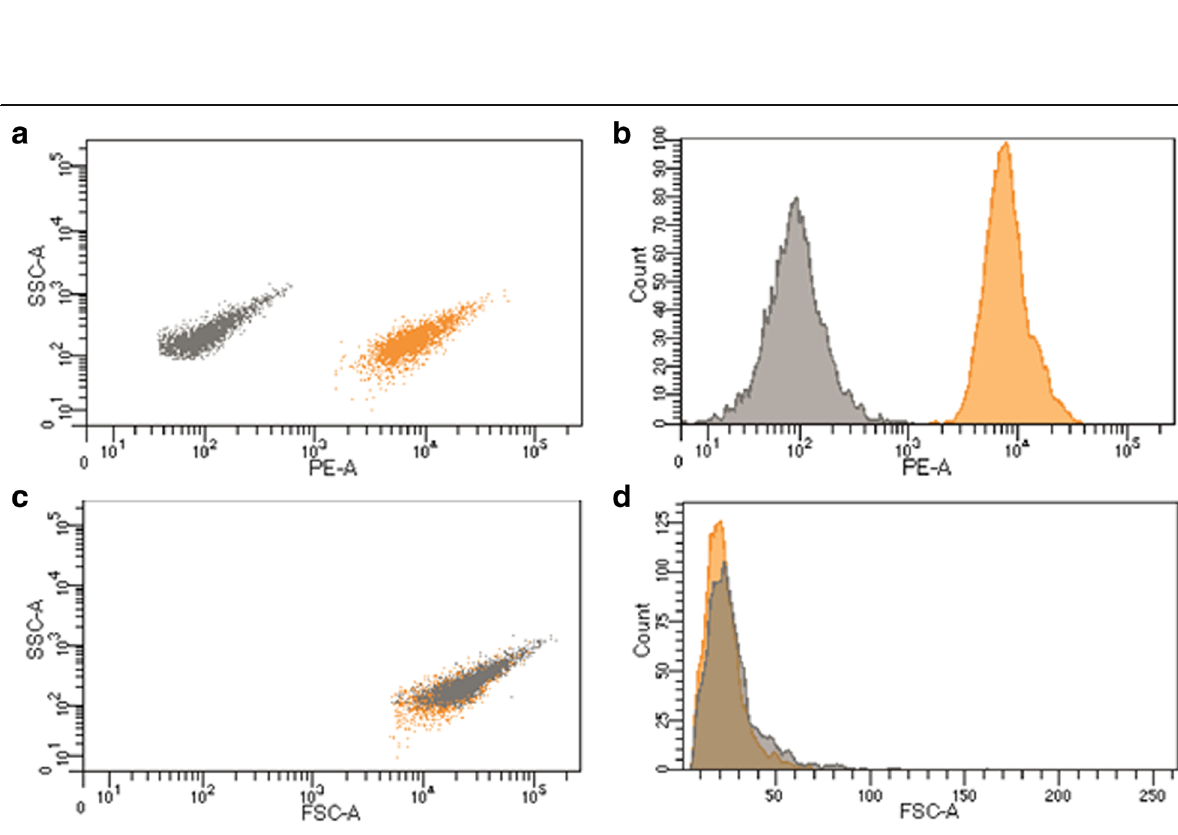
Fig. 4 Detectability of QD-encoded polyelectrolyte microcapsules by flow cytometry: a microcapsule dot-plot profile in SSC-PE channels; b microcapsule distribution histogram in PE channel; c microcapsule dot-plot profile in SSC-FSC channels; d microcapsule distribution histogram in FSC channel. QD-free microcapsules (placebo) were used as a control and are shown in gray, whereas those encoded with CdSe/ZnS quantum dots (fluorescence emission maximum at 590 nm) are shown in orange. The number of analyzed events was equal to 2500. The dot-plots and histogram axes are shown as SSC-A, FSC-A, PE-A, where A means the data are represented by signal